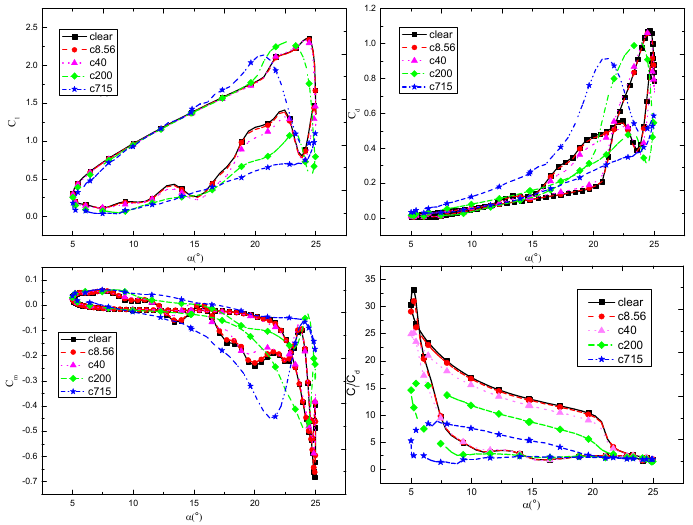
Figure 6. Effect of different concentrations of particles on the aerodynamic performance of the airfoil.